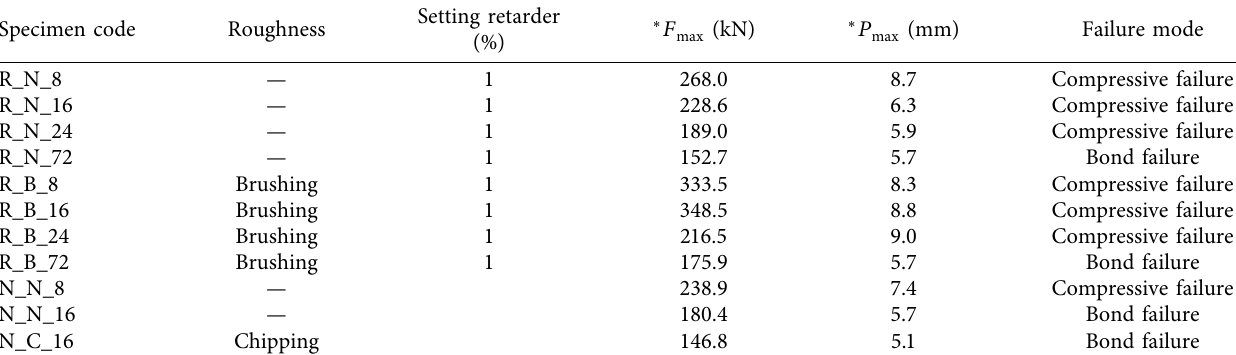
Table 3: Summary of test result on the 28 th